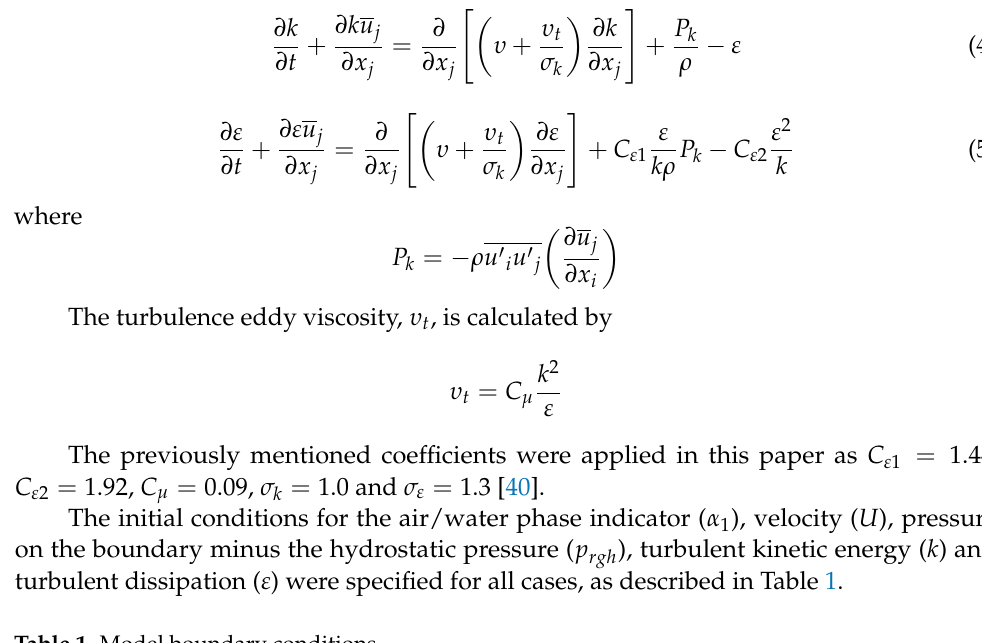
Table 1. Model boundary